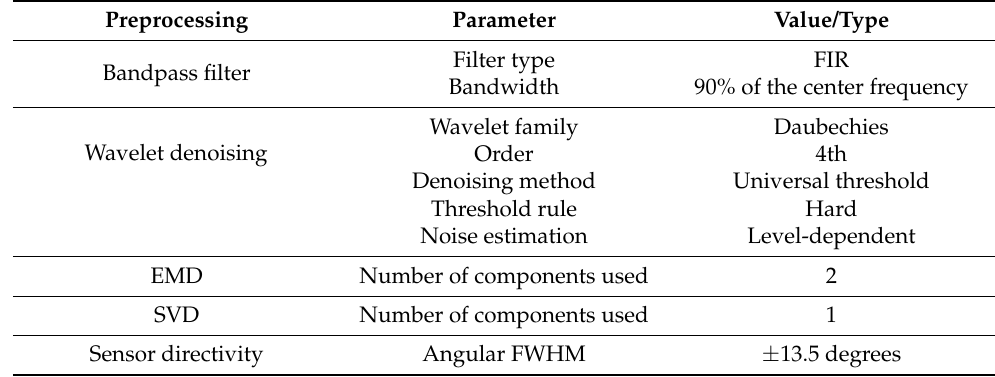
Table 1. Parameters used for each preprocessing method.